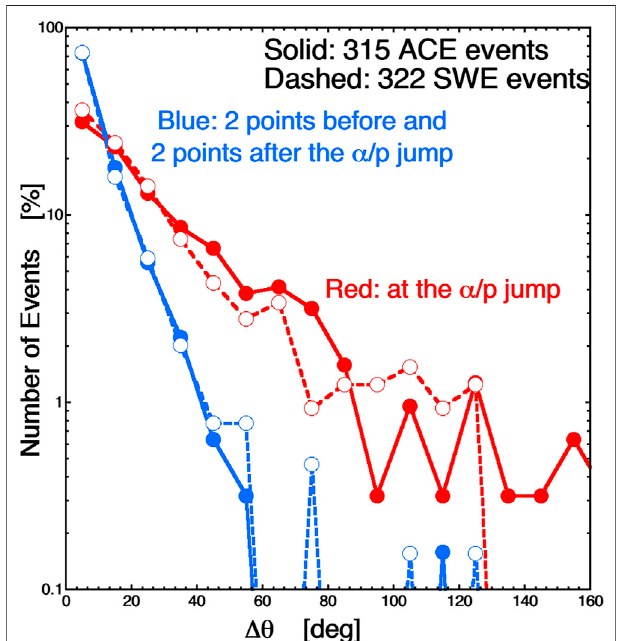
FIGURE 11 | The distribution of magnetic- fi eld-direction change Δθ values from one data point to the next. The red curves are for times when α /p boundariesarecrossedandthebluecurvesarefortwodatapointsbeforeand afterthecrossingofthe α /pboundaries. ThesolidcurvesarefortheACE α /p boundaries and the dashed curves are for the WIND boundaries.